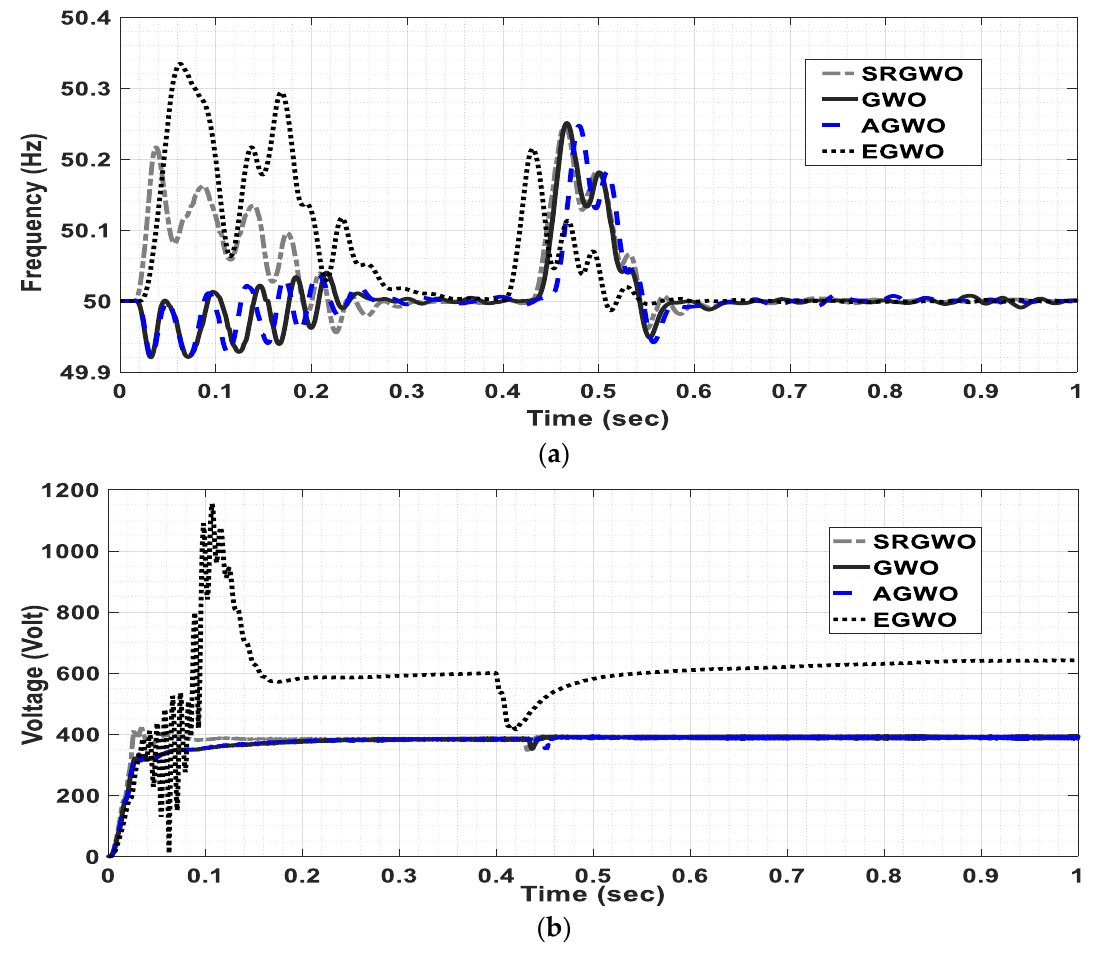
Figure 8. ( a , b ) The comparison of SRGWO with EGWO, AGWO and GWO (a ) Frequency regulation ( b )Voltage regulation. ( b ) Voltage